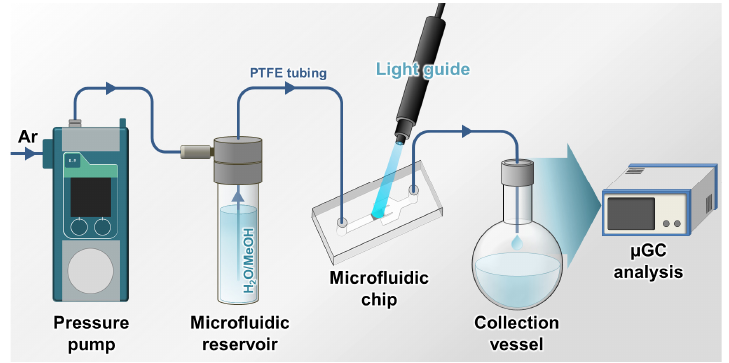
Figure 3. Setup used for the investigation of H 2 production under micro fl uidic conditions.